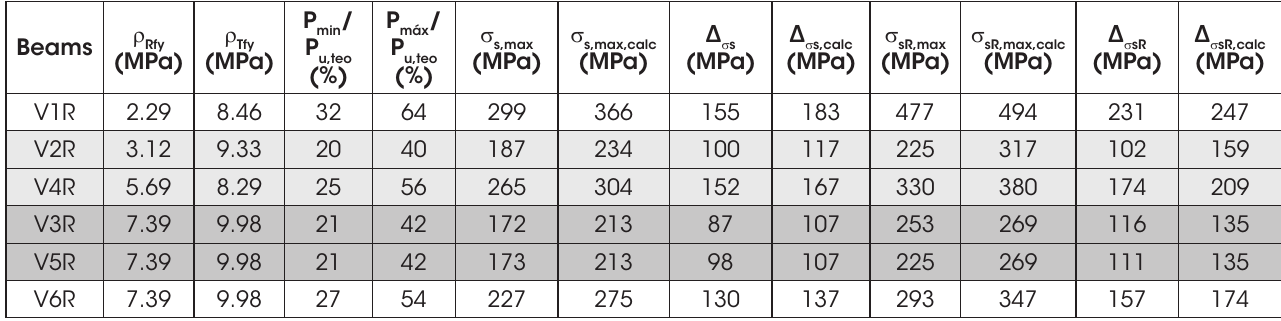
Maximum normal stresses and variation of these stresses in the longitudinal tensile reinforcement at the beginning of cyclic loading, obtained from measured and calculated steel strains